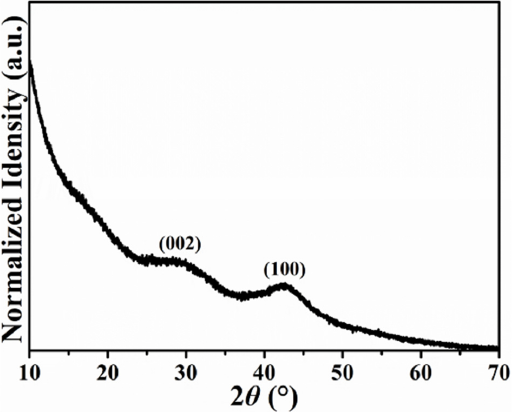
Figure 1. Normalized PXRD pattern of H@H composite material.